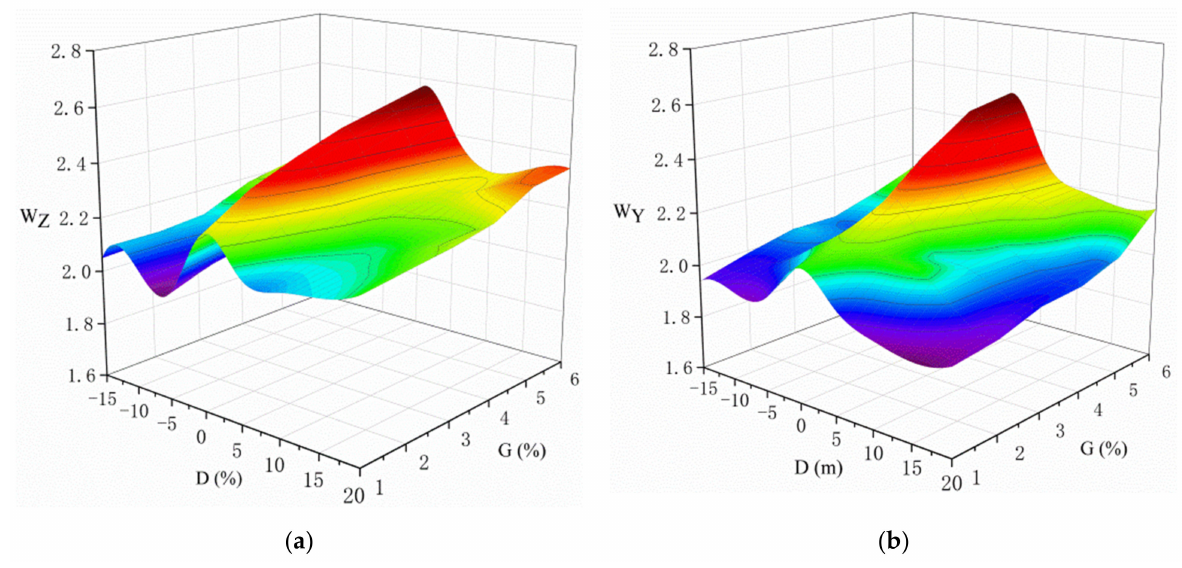
Figure 14. The vibration stability under R = 100 m working condition: ( a ) The vertical sperling index of the vehicle body; ( b ) The lateral sperling index of the vehicle body.